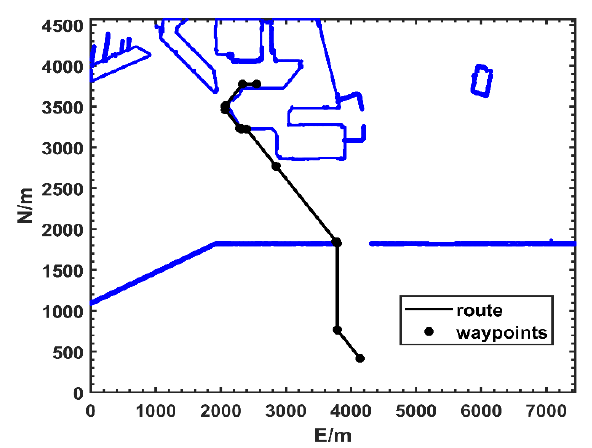
Figure 9. Path planned through smooth-RRT method.